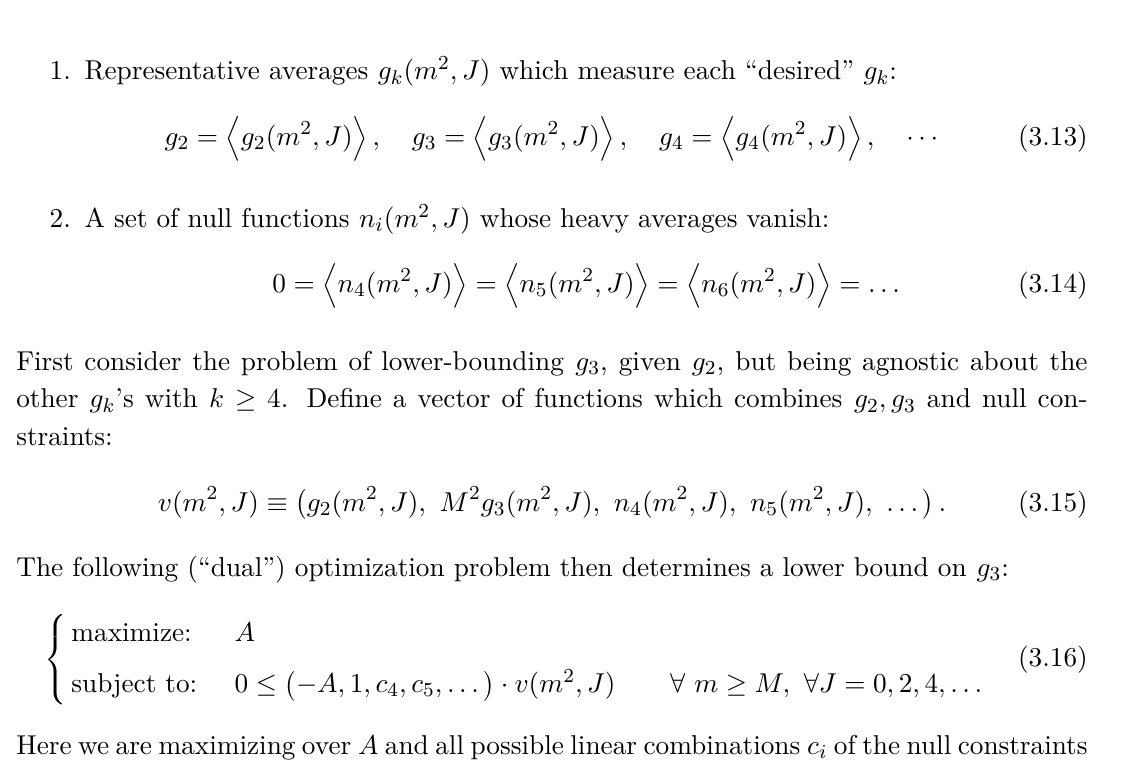
Figure 6. The non-negative function F ( m 2 , J ) returned by SDPB when maximizing the lower bound for ˜ g . The spin 4 curve is particularly enlightening because it features a double 3